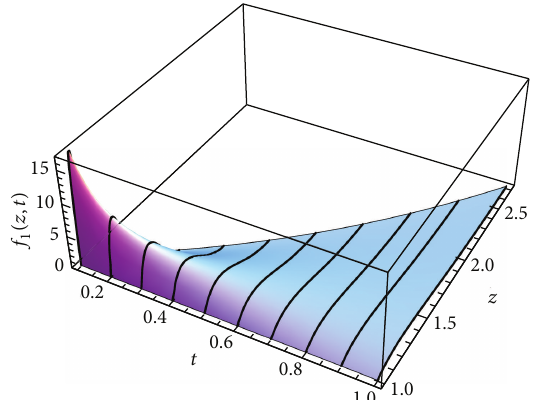
Figure 2: Plot of 𝑓 1 (𝑧, 𝑡) given by (42) in Example 11 at different values of 𝑡 = {0.1, 0.2, 0.3, . .. ,1} (corresponding to the solid lines) in the case that 𝐴 ∼ Be (2;3) , 𝑡 0 = 0 , and 𝑧 0 = 1